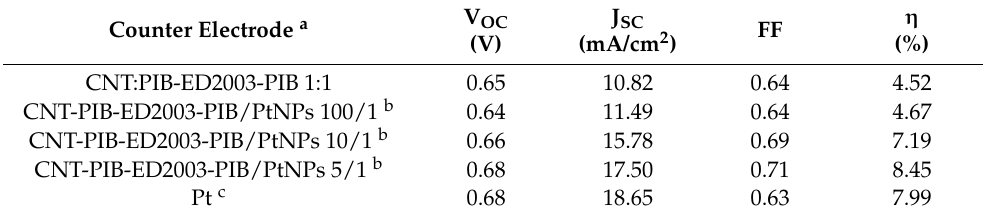
Table 3. Efficiency of counter electrodes made of dispersant/carbon nanotubes at different weight ratios and carbon nanotubes/platinum nanoparticles at different ratios under FTO